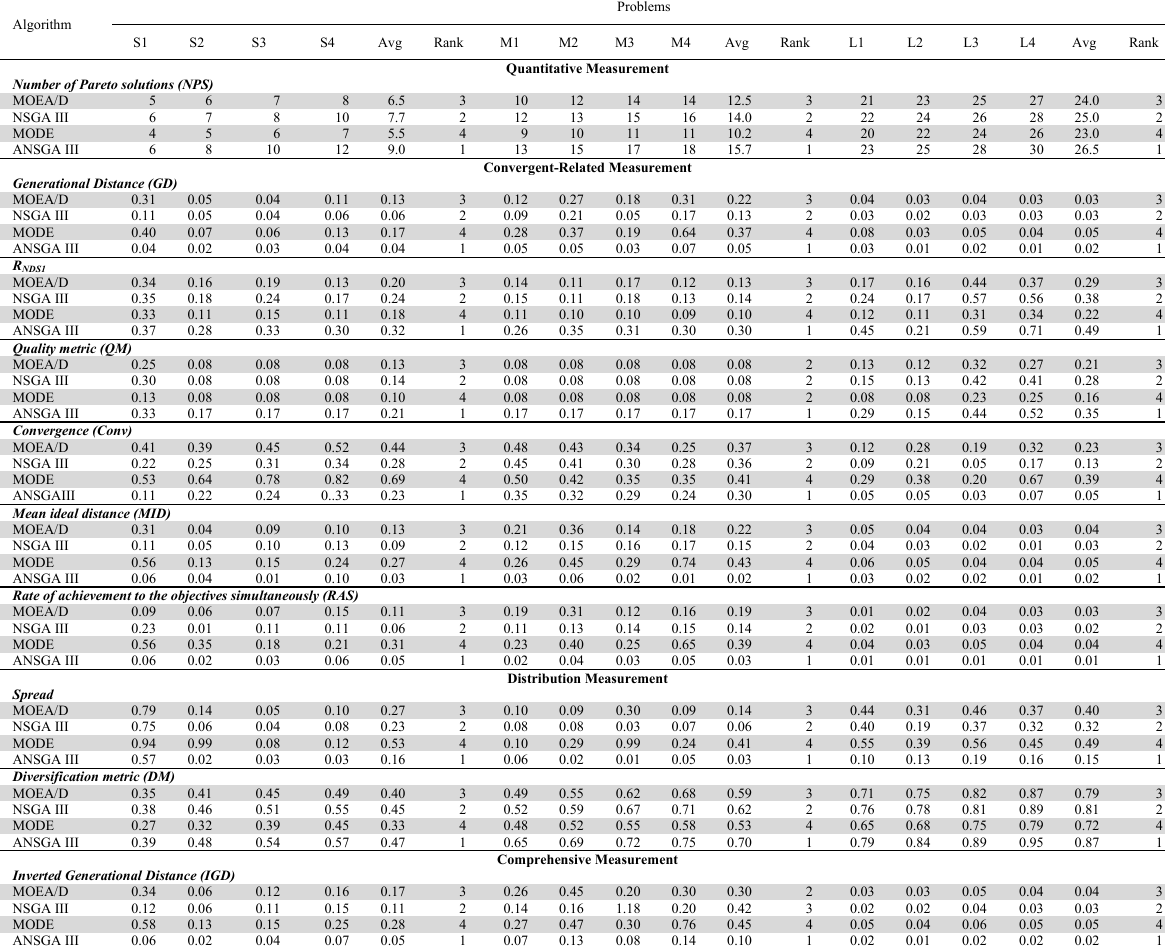
Pareto-based measurements obtained by the different four algorithms